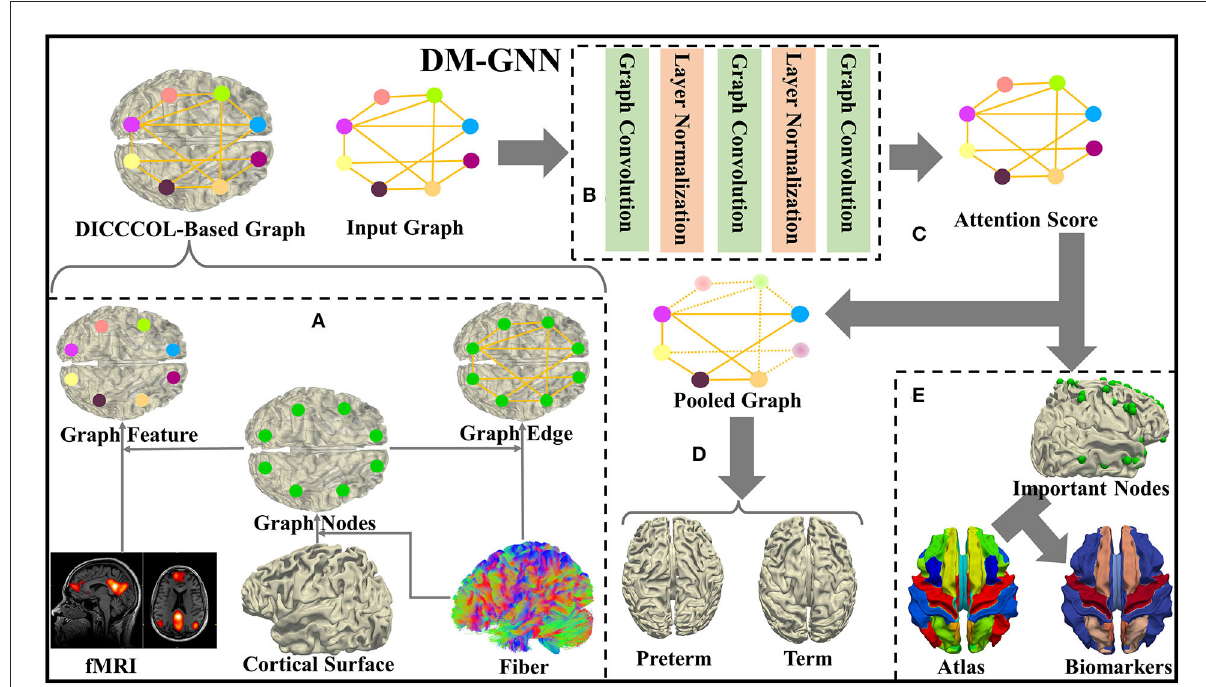
FIGURE1 Framework of proposed dense individualized and common connectivity-based cortical landmarks (DICCCOL)-based multi-modality graph neural network (GNN). (A) Graph generation. (B) Feature extraction. (C) Graph pooling. (D) Classification. (E) Biomarker